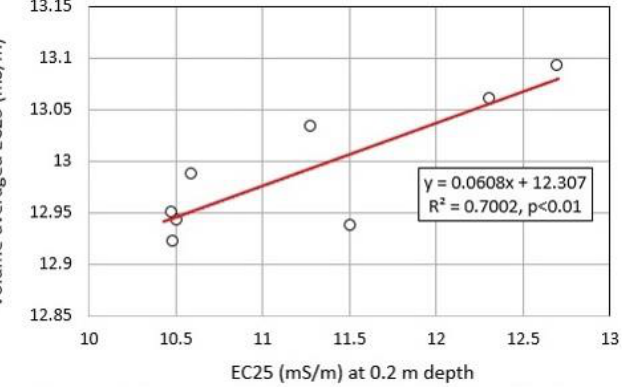
Figure 7. Relation between EC25 at 0.2 m depth and the volume-averaged EC25 calculated using the vertical EC25 profiles in 2020–2021 and the bathymetric map (Figure 1).